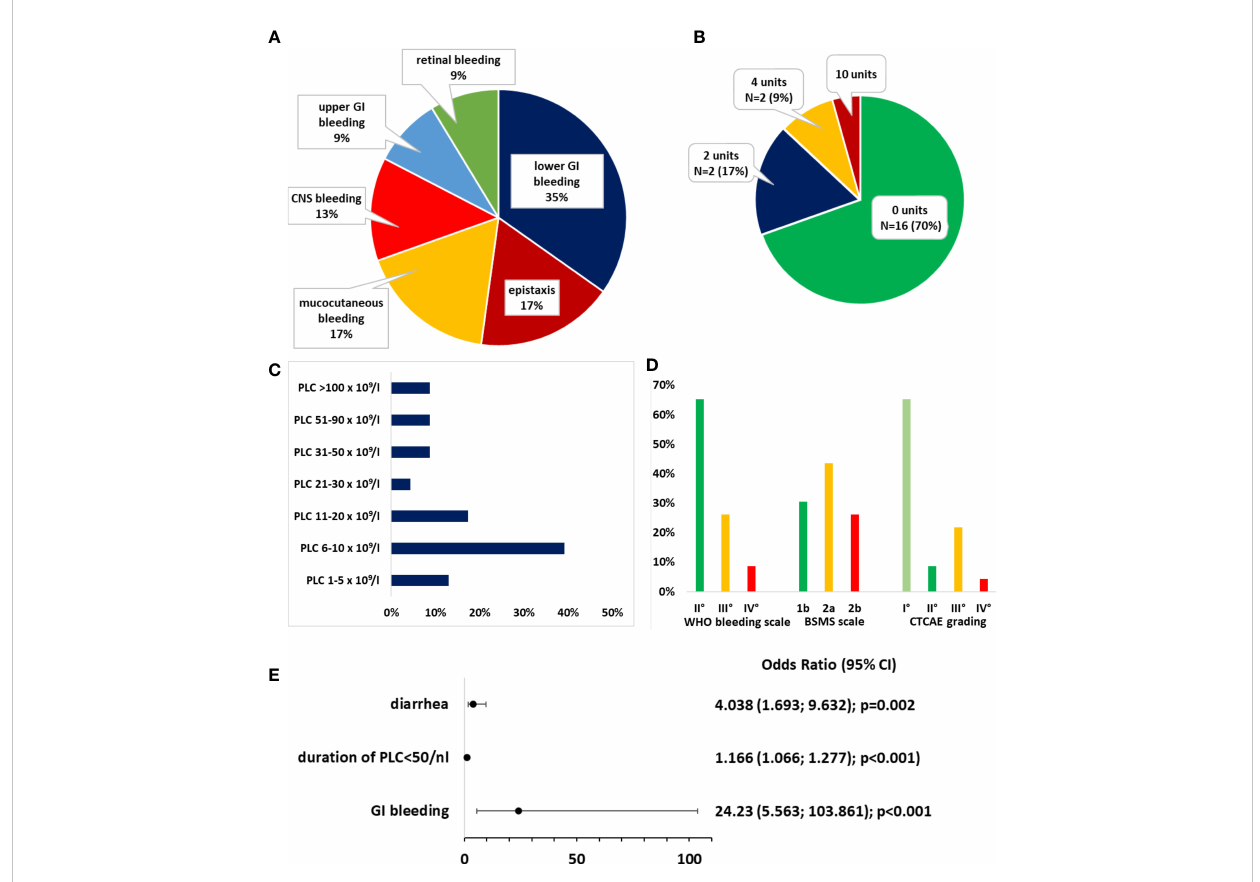
FIGURE 2 Bleeding events. (A) Distribution of bleeding sites. (B) Distribution of transfusion requirements for packed red blood cells. (C) Distribution of platelet count (PLC) at bleeding onset. (D) Distribution of bleeding severity according to the World Health Organization (WHO) bleeding scale, Bleeding Severity Measurement Scale (BSMS), and NCI Common Terminology Criteria for Adverse Events (CTCAE). (E) Odds ratios (ORs) for the risk of bleeding. A binomial logistic regression model was generated after forward